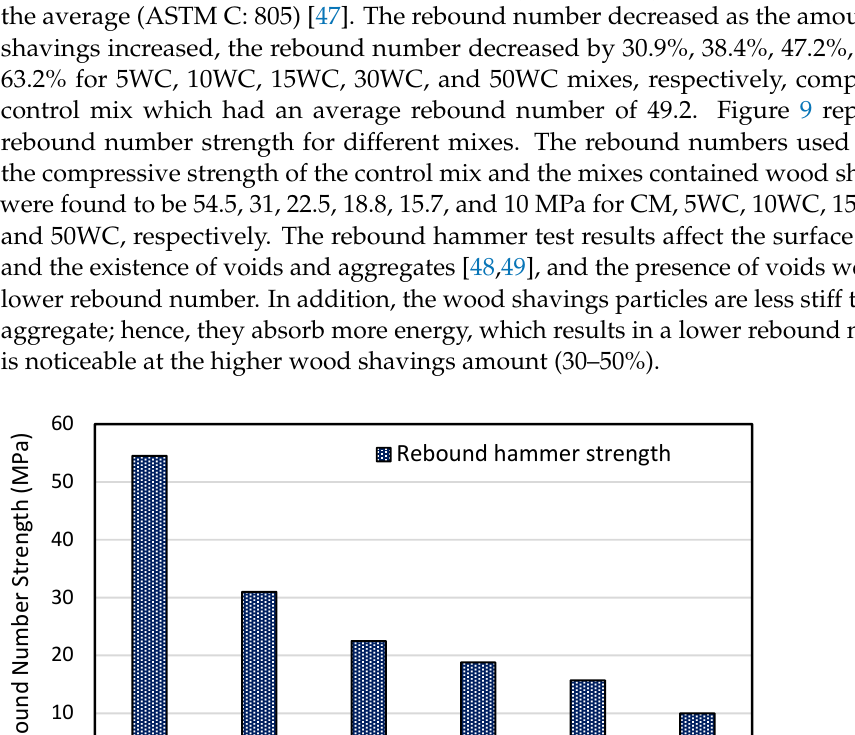
Figure 8. Ultrasonic pulse velocity results.